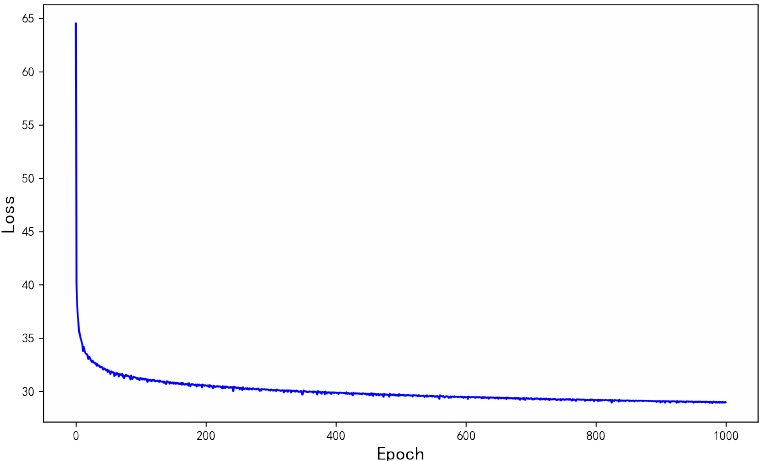
Figure 1. Training process for Concrete dataset when learning the rate is 0.001.